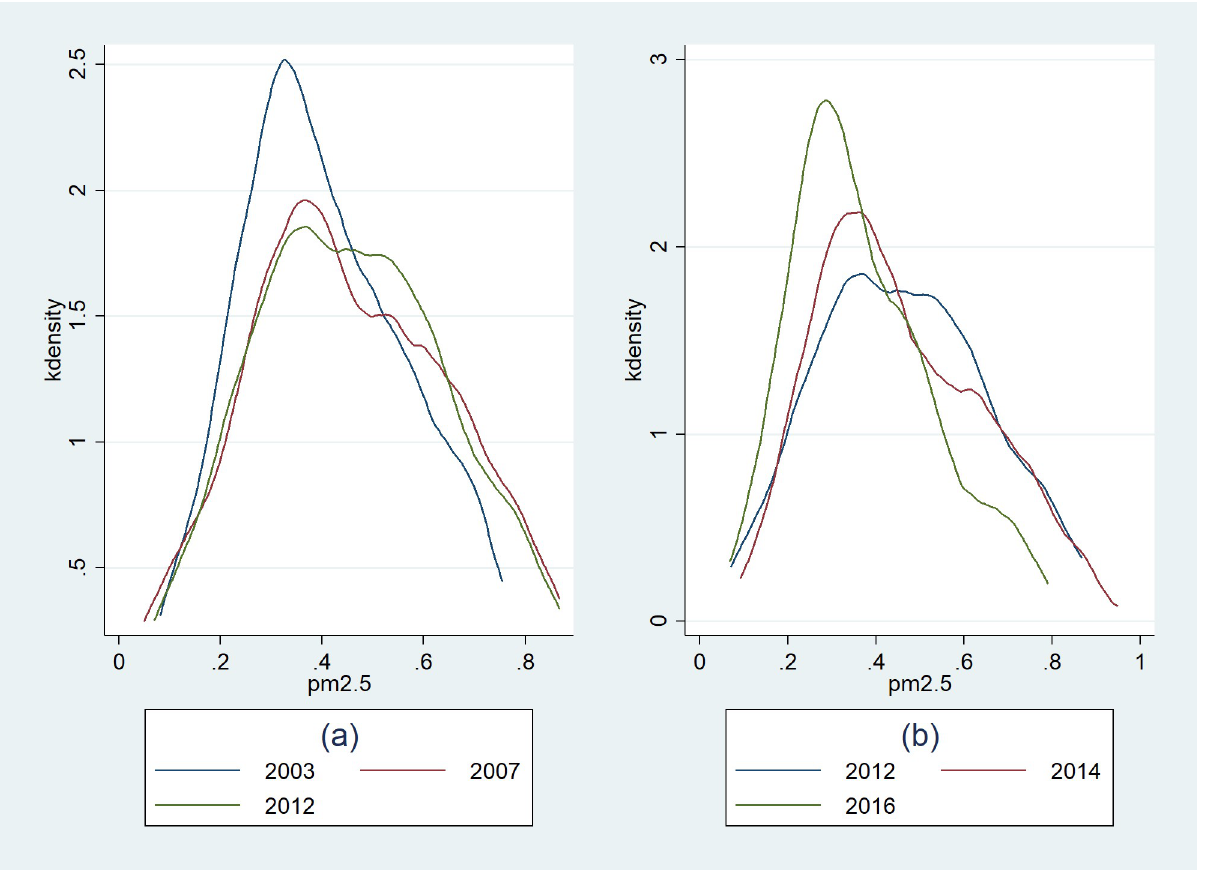
PLOS ONE | https://doi.org/10.1371/journal.pone.0263883 May 24,